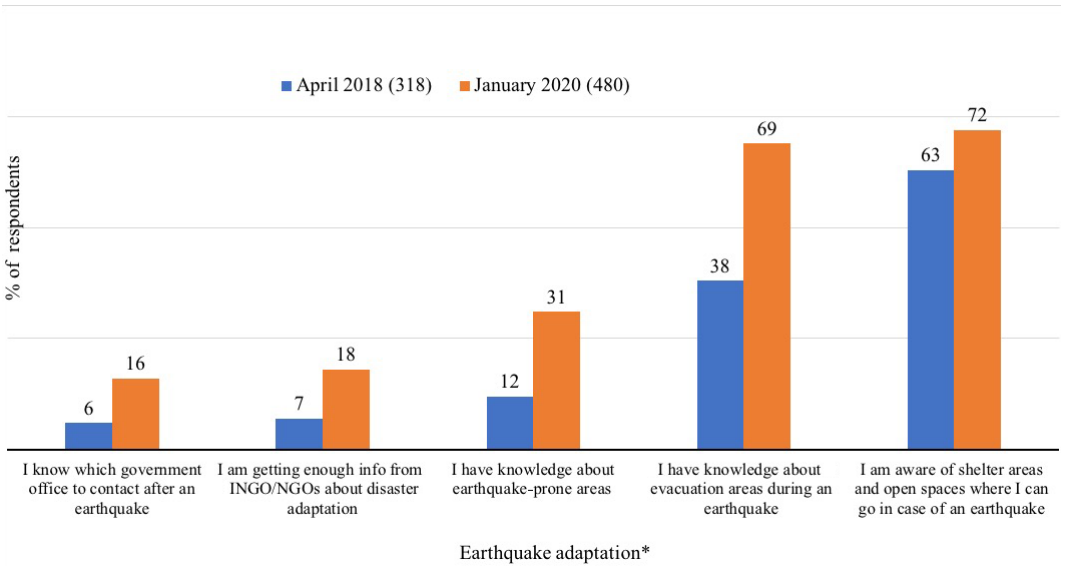
Figure 11. Students’ ideas about earthquake adaptation (Q15), before and after the initiation of our education program. Note: ∗ – Multiple answers were possible.